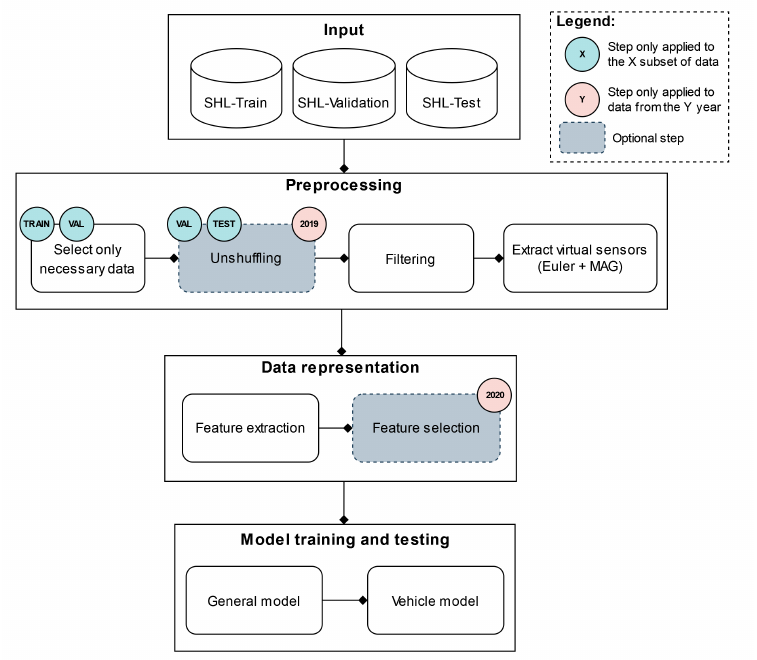
Figure 3. The general structure of the 2019 and 2020